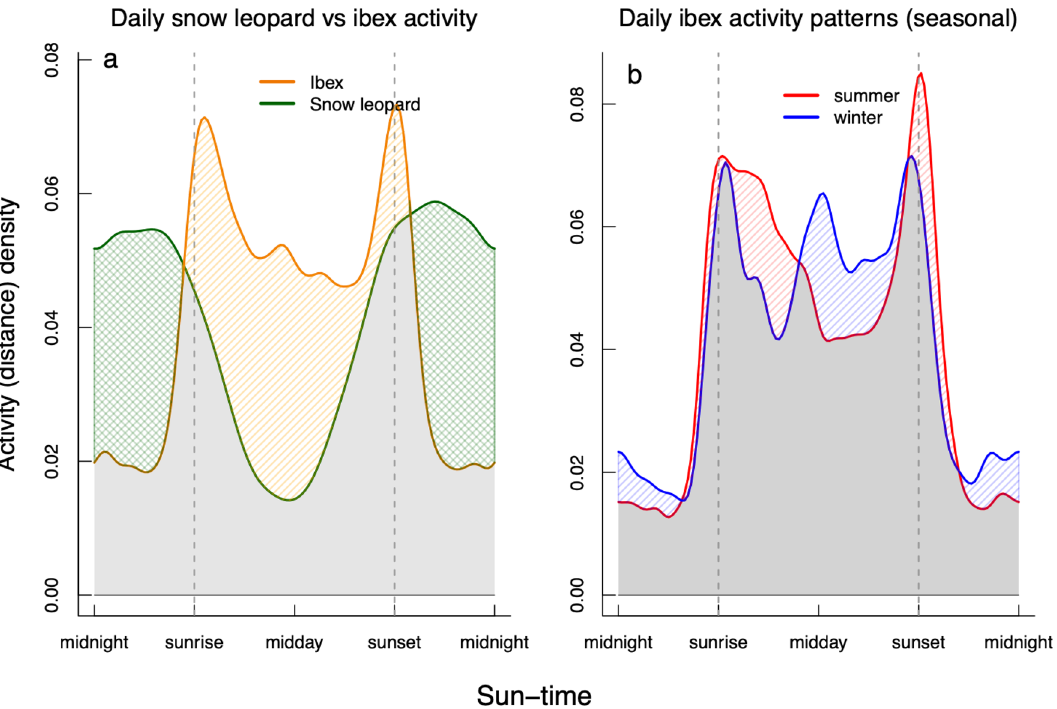
Figure 3. The relative proportion of activity across the 24-h cycle based on GPS movement data for: ( a ) adult snow leopards (green) versus adult ibex (orange), and ( b ) adult ibex during winter (blue) and summer (red). The activity density values have no absolute meaning, but rather are relative measures of probability density calculated from the raw movement data. The time of all observations has been standardised along the x-axis using ‘sun-times’; where the time of observation on each day is calibrated to sunrise, solar-noon (midday) and sunset. These overlap plots show the activity overlap (in grey) between: ( a ) snow leopards and ibex: for periods when snow leopards use more of their activity budget relative to ibex this is shaded (cross-hatched) green, for periods when ibex use more of their activity budget relative to snow leopards is coloured orange. ( b ) Ibex winter and summer activity: for periods when ibex are more active during winter (shaded blue) or during summer (shaded there is no need for a trade-off between the success of stalking and the final ambush, as the pattern could be related primarily to the approach phase of the hunt. Both explanations are consistent with our finding that snow leopard night-time activity marginally declined as moon illumination increased. A moonlit night in the vegetation-sparse landscape is relatively bright, meaning that moonlight could be expected to reduce the ability of snow leopards to stalk their prey undetected. Ambient temperature appeared to have a considerable modifying effect on daily snow leopard activity based on seasonal changes in activity patterns. In summer, when daytime temperatures in the Gobi Desert can reach 40 °C, snow leopards increased their activity during the coolest times of the day (i.e. night and dawn). In winter when night-time and dawn temperatures can reach − 30 °C, snow leopards increased their activity during the warmest parts of the day (i.e. daytime and dusk). Animals are thermoneutral when they do not need to actively regulate their body heat. The thermoneutral range for snow leopards is not known, however, other medium- sized and large felids less adapted to cold climates have a thermoneutral range of 9 to 37 °C 28 . The Arctic fox ( Vulpes lagopus ) , a species well-adapted to polar conditions, are thermoneutral down to − 7 °C with their winter coat and 5 °C in summer 42 . We expect that winter temperatures in the Gobi Desert commonly fall below the lower thermoneutral temperature for snow leopards, and climb above this range in summer. Seasonal changes in snow leopard activity seemed to be in response to their need for regulating their body temperature. Wind has a dramatic effect on body temperature maintenance in snow leopards (Ö Johansson, personal observation), and thus by being more active during the warmer daytime periods in winter and increasing their sheltering during the coldest times, it is likely snow leopards were conserving energy. In summer, the daytime temperatures in the high-altitude and vegetation-sparse mountainous habitat are exacerbated by the intense solar radiation. With limited water sources in the Gobi, which possibly limits their ability to pant as the principal method used by felids to cool down 43 , adjusting activity to cooler time periods in summer presumably allows snow leopards to conserve energy and water, and avoid hyperthermia. Similarly, the ibex in our study area also appeared to adjust activity patterns for thermoregulation during daylight hours; in summer, activity increased in the morning compared to an increase in activity in the afternoon and evening in winter. We expect that with temperatures in High Asia increasing at a higher rate than the global average in recent years 31 , snow leopards will likely respond to future